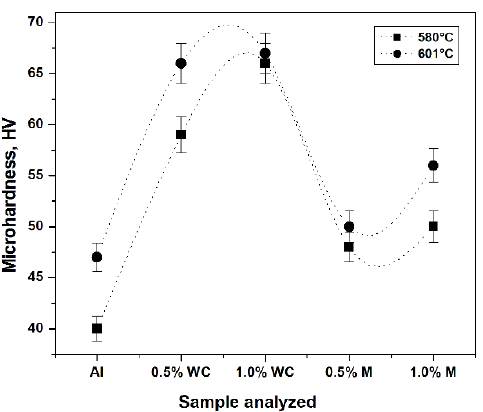
Figure 6. Results of the microhardness evaluated in the samples with different compositions and sintered at different temperatures.